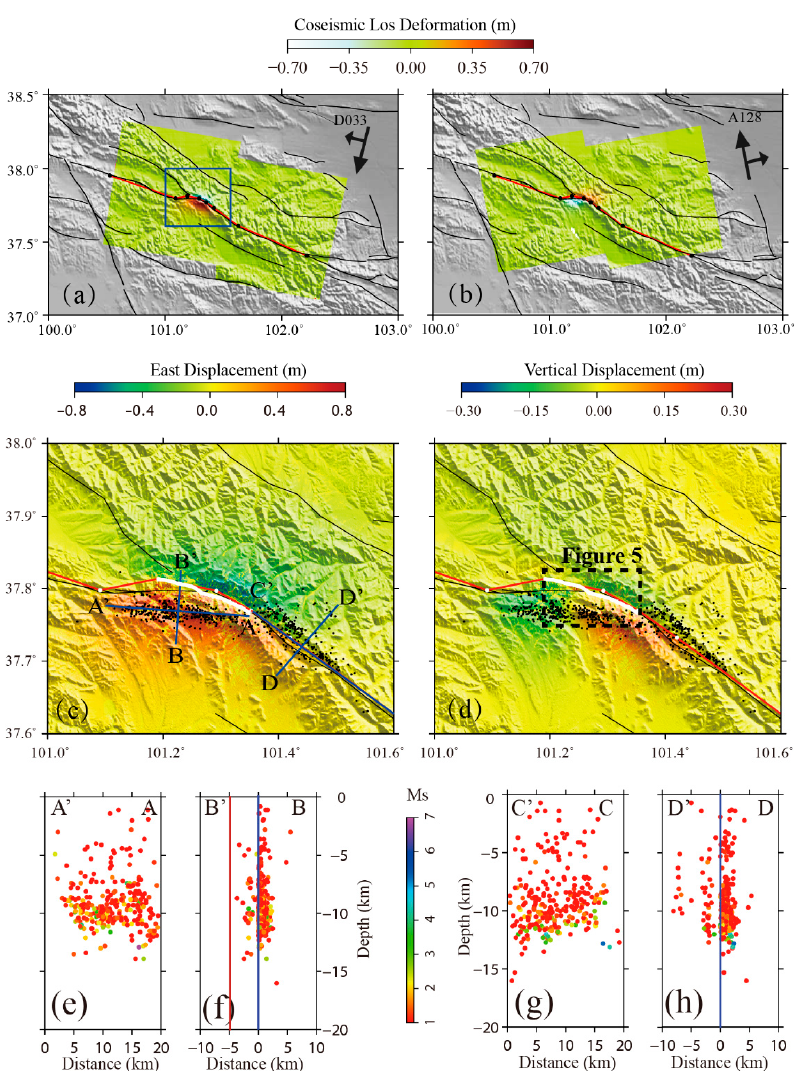
Figure 4. InSAR coseismic deformation field and aftershock distribution following the 2022 Menyuan earthquake. ( a ) Deformation field from the D033 orbit. ( b ) Deformation field from the A128 orbit, in which black lines indicate active faults and red lines with black dots indicate rupture traces and turning points used in the InSAR coseismic inversion, respectively. ( c , d ) display the details within the blue rectangle in ( a ), in which black lines exhibit active faults, red lines with white dots indicate the fault trace and turning point, white lines indicate the surface rupture traces, black dots indicate fine positioning after aftershock distribution, and the purple star indicates the epicenter location determined from the focal mechanism. ( c ) E–W coseismic deformation field (red and blue represent eastward and westward motions, respectively), where the blue line indicates the aftershock profile. ( d ) Vertical coseismic deformation field (red and blue represent upward and downward motions, respectively). The black-dotted rectangle is the location of Figure 5. Aftershock distribution along the ( e ) A–A’ and ( f ) B–B’ cross-sections, where the red line indicates the location of the deformation trace and the blue line indicates the location of concentrated aftershocks. ( g ) Aftershock distribution along the C–C’ cross-section. ( h ) Aftershock distribution along the D–D’ cross-section, in which the blue line indicates the location of concentrated